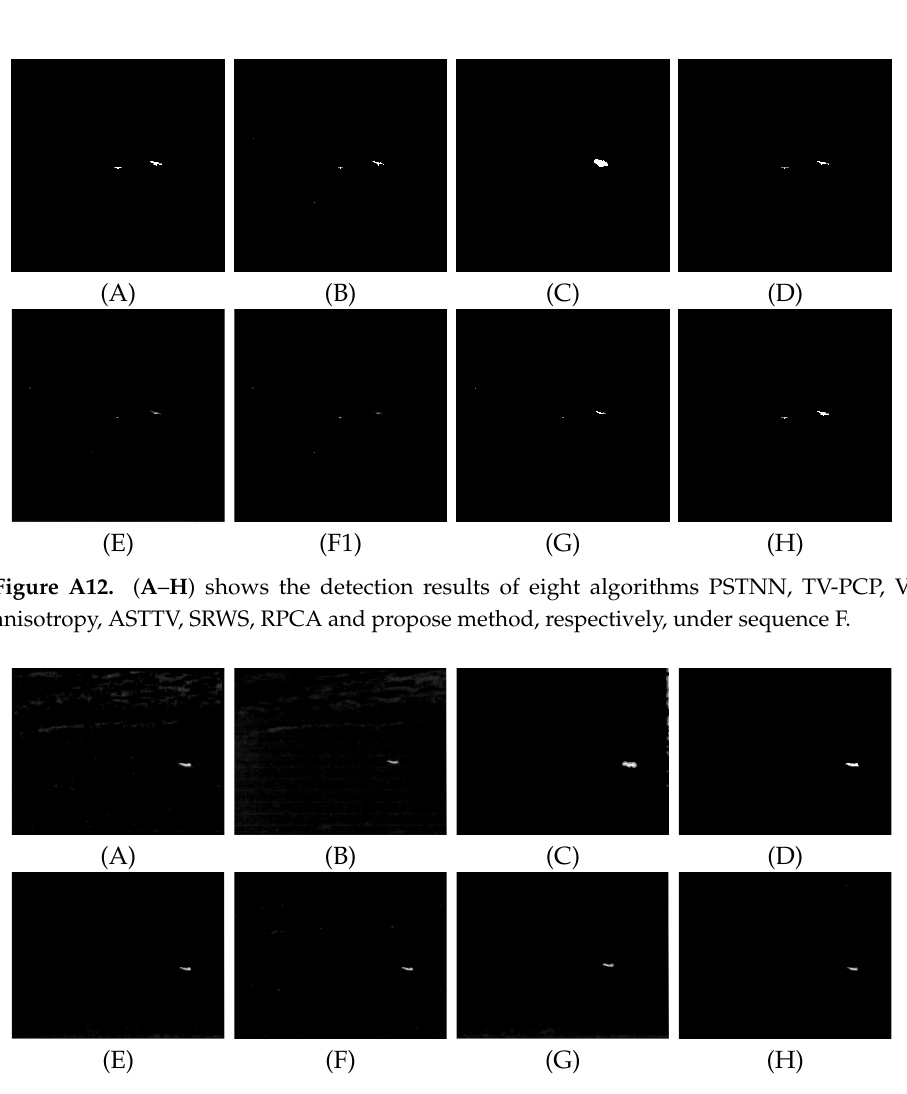
Figure A13. ( A – H ) shows the detection results of eight algorithms PSTNN, TV-PCP, VNTFR, anisotropy, ASTTV, SRWS, RPCA and propose method, respectively, under sequence G.